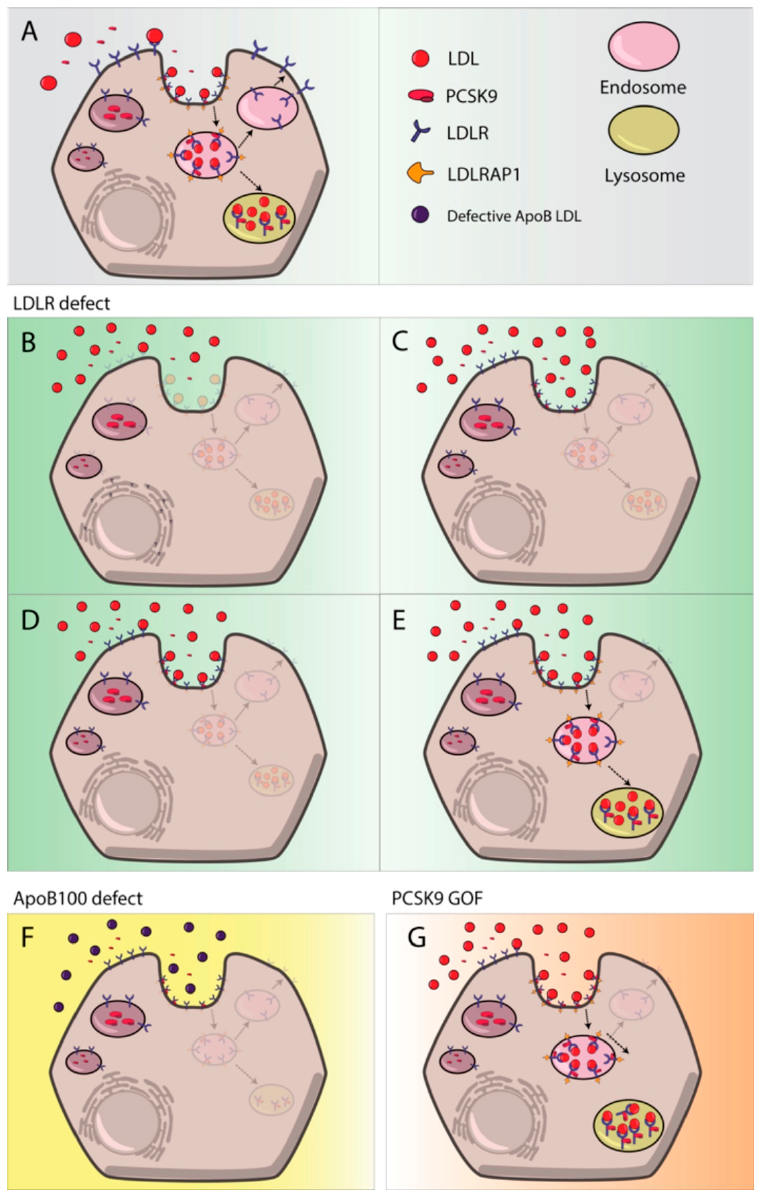
Figure 3. Most frequent LDL catabolism defects. ( A ) LDL uptake process by LDLR; ( B ) class 2 LDLR mutants, LDLR retention in the endoplasmic reticulum; ( C ) Class 3 mutants, no LDL-LDLR binding; ( D ) class 4 mutants, impaired LDL-LDLR complex internalization; ( E ) class 5 mutants, recycling defect; ( F ) defective ApoB-100 derived impaired LDL-LDLR binding; ( G ) PCSK9 gain of function mutant.